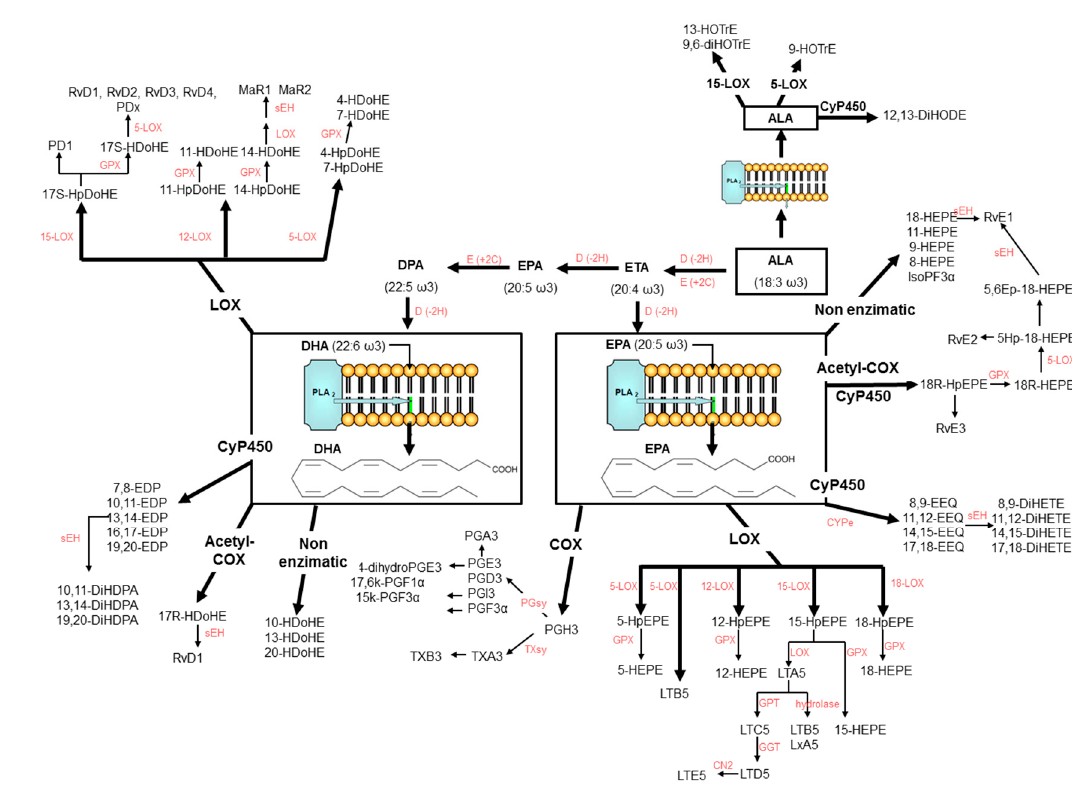
Figure 1. ( a ): Cascade of formation of lipid mediators from ω -6 LA, DGLA and ARA. ( b ): Cascade of formation of lipid mediators from ω -3 ALA, EPA, and DHA.